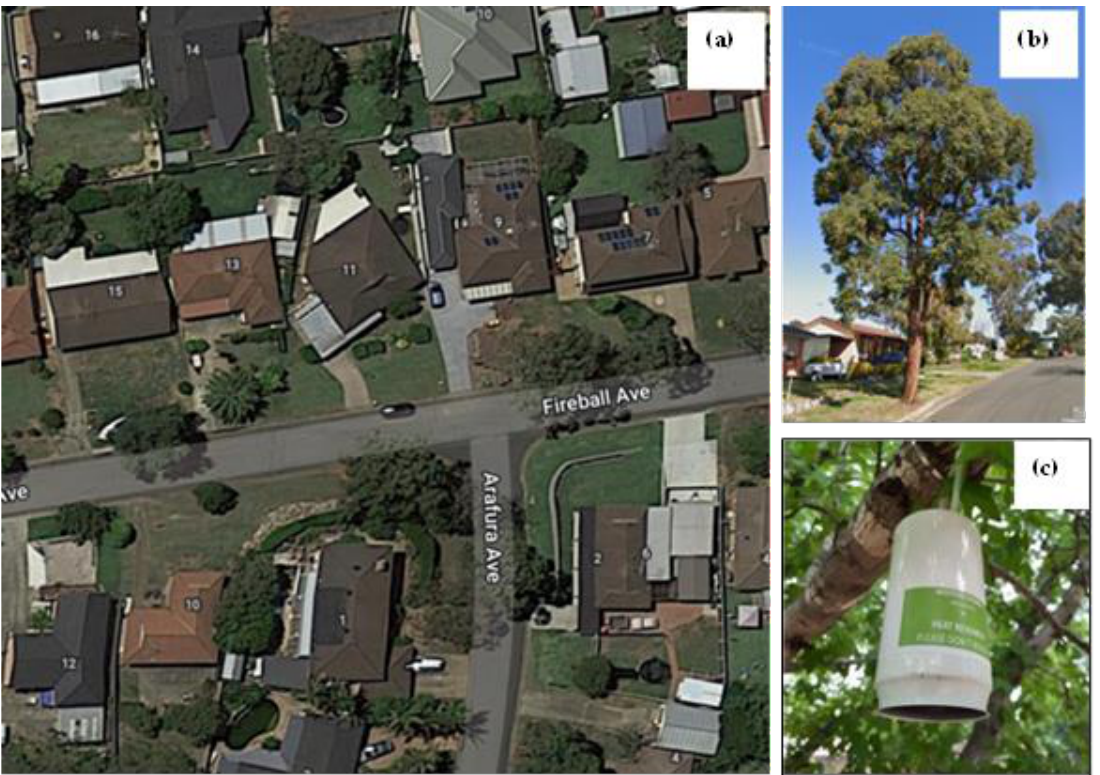
Figure 1. ( a ) Example of the urban morphology of one of the studied suburbs, Cranebrook, ( b ) street trees ( Eucalyptus microcorys located on Arafura Avenue, Cranebrook), and ( c ) sensor and shielding affixed to a tree. The street map of Cranebrook shows that trees are growing on nature strips (verges) and at varying distances from houses. Images of ( a , b ) were sourced from google maps.